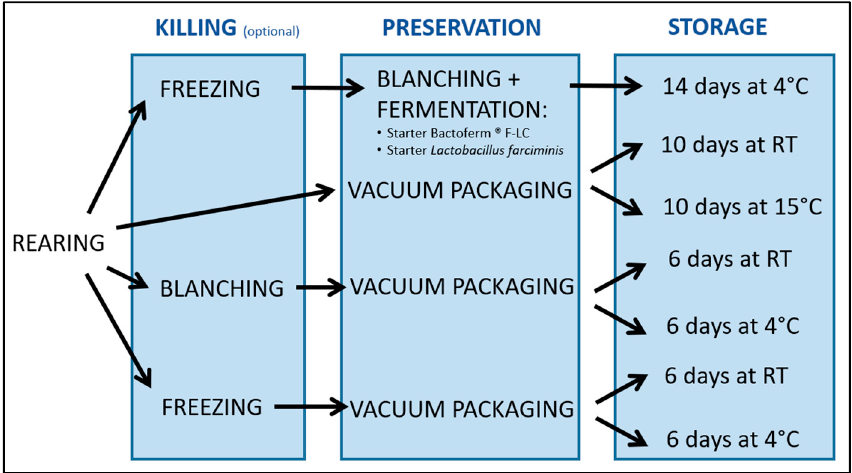
Figure 1. Overview of the experimental design (RT: room temperature).